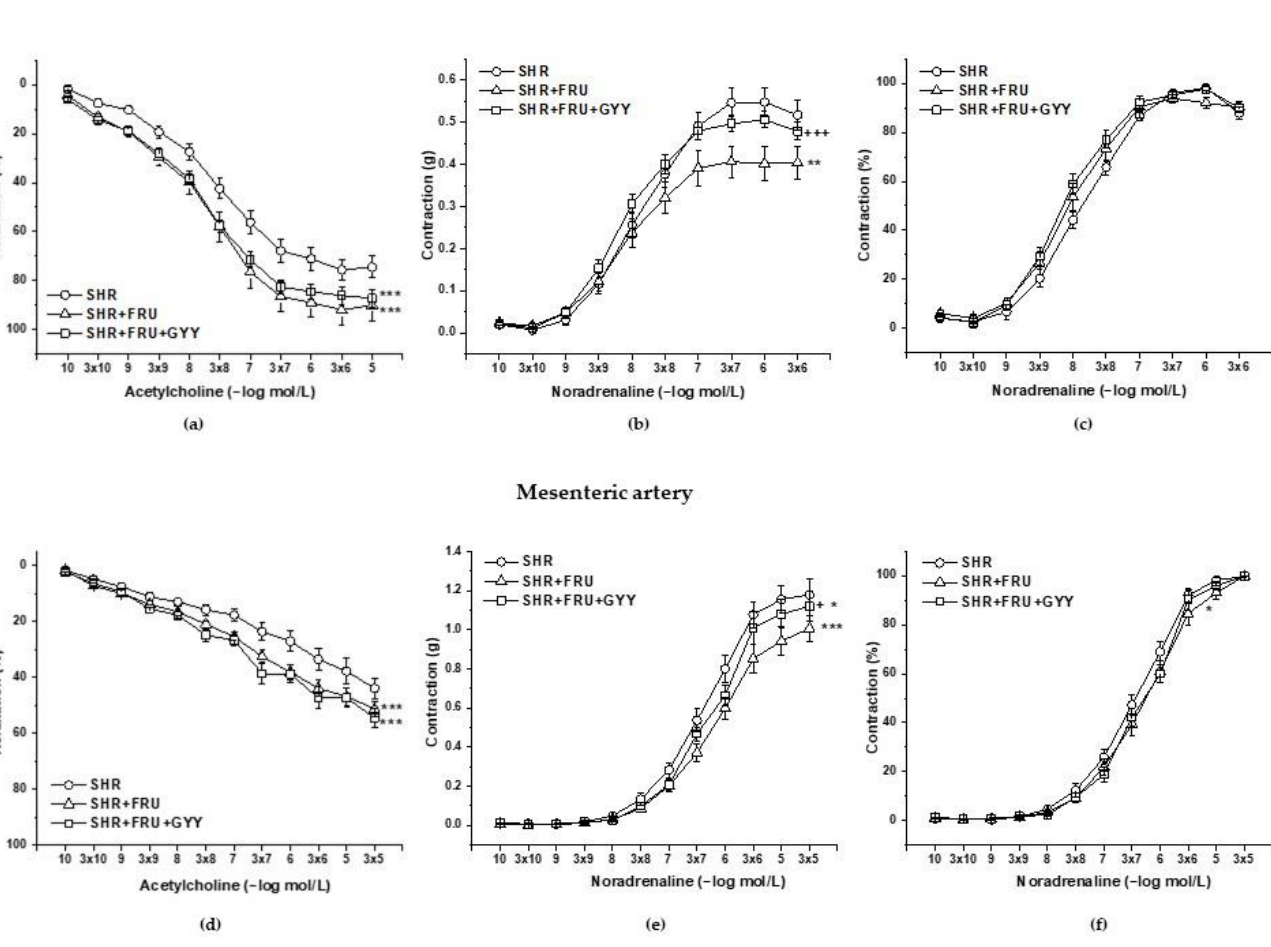
Figure 2. Endothelium-dependent vasorelaxant response of the thoracic aorta ( a ) and mesenteric artery ( d ). Noradrenaline-induced a contractile response of the thoracic aorta ( b ) absolute response, ( c ) percent values of the maximum response), mesenteric artery ( e ) absolute response, ( f ) percent values of the maximum response). Arteries were isolated from spontaneously hypertensive rats (SHRs), SHRs treated with fructose (SHR+FRU), and SHRs treated with fructose and GYY-4137 (SHR+FRU+GYY). The results are presented as the mean ± S.E.M. Statistical analysis was performed by two-way ANOVA with a Bonferroni post-hoc test. * p < 0.05, ** p < 0.01, and *** p < 0.001 vs. SHR, + p < 0.05 and +++ p < 0.001 vs. SHR+FRU.